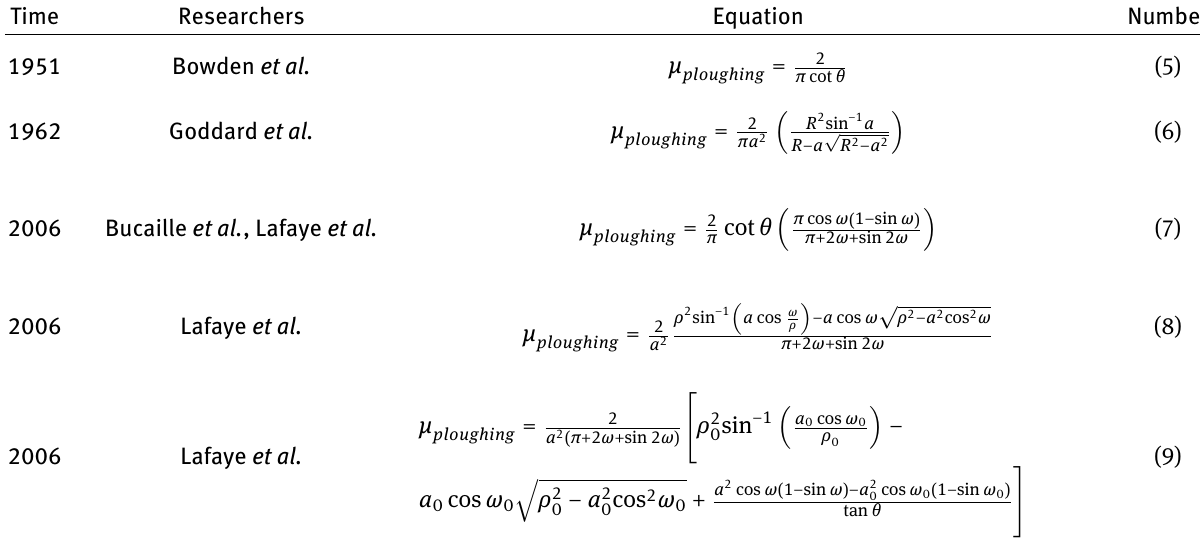
Table 1: The process of developing the friction coeflcient